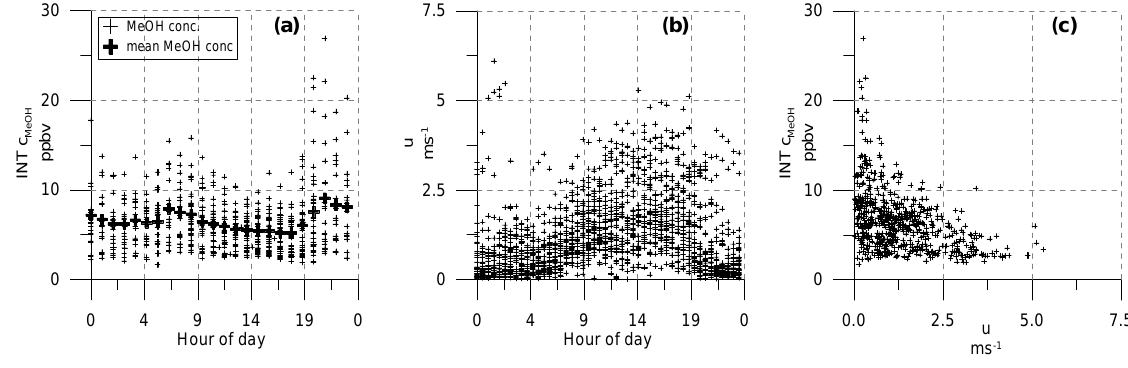
Fig. 4. Diurnal cycle of (a) methanol concentrations ( c MeOH ) including hourly mean values above the intensive field, and (b) horizontal wind velocities ( u ). (c) shows the scatter plot of methanol concentrations vs horizontal wind velocity. The data cover the period